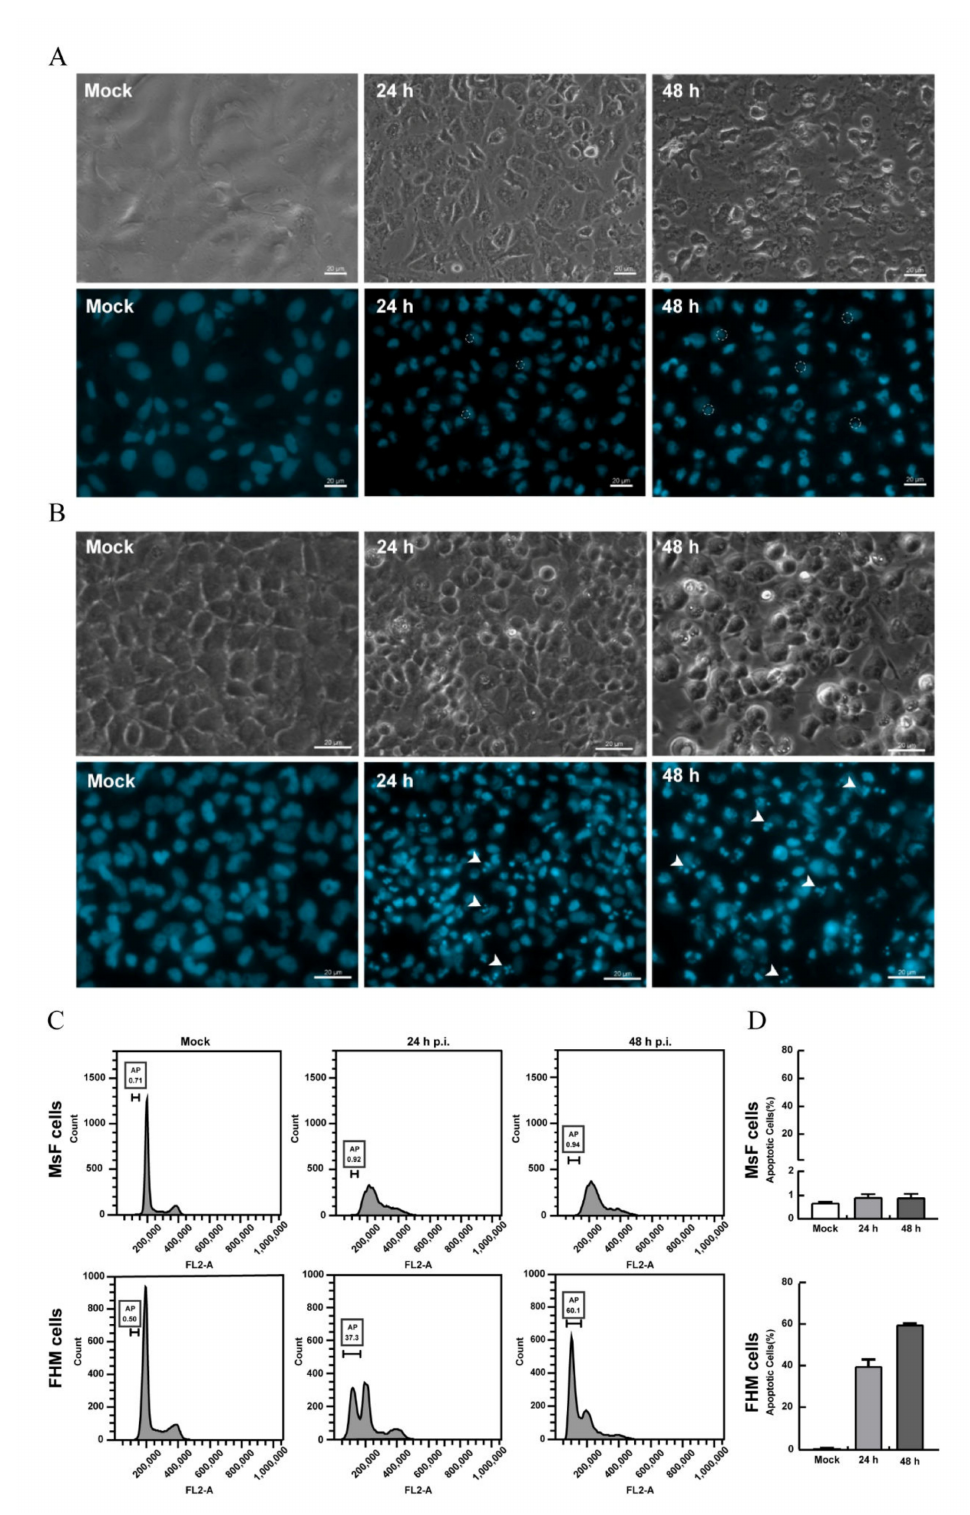
Figure 4. LMBV infection induced non-apoptotic cell death in MsF cells. ( A ) The nuclear morphology of mock- or LMBV-infected MsF cells. Few apoptotic bodies were observed in LMBV-infected MsF cells. Circles indicate the assembly sites. ( B ) The nuclear morphology of mock- or LMBV-infected FHM cells. Numerous apoptotic bodies were observed in LMBV-infected FHM cells. Head arrows indicate apoptotic bodies. ( C ) DNA content analysis in LMBV-infected MsF and FHM cells. ( D ) The percentages of the sub-G0/G1 phase (apoptotic cells) in LMBV-infected MsF and FHM